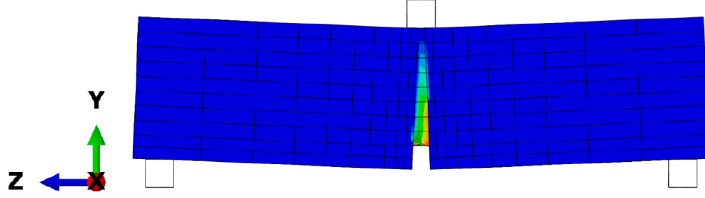
Figure 7. Deformation of a beam using a three-point bending test with the Finite Element Method.